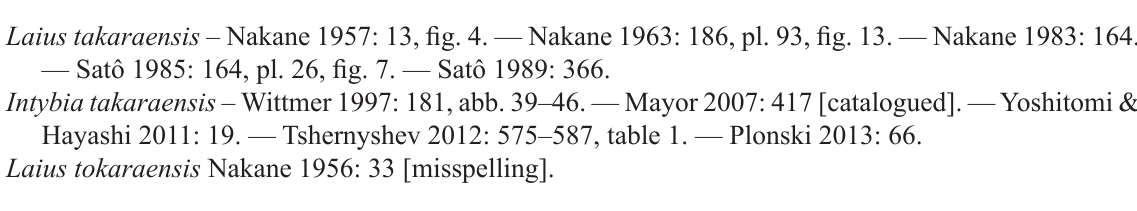
Body (Fig. 1F) oval, shining, sparsely covered with fulvous hairs. Coloration of head, pronotum and elytra black with bluish luster; antennae yellow, with apical 8 or 9 segments black; elytra with a wide yellow fascia just before the middle; tibiae, trochanters, apex of coxae, fore femora; apical portion of middle femora